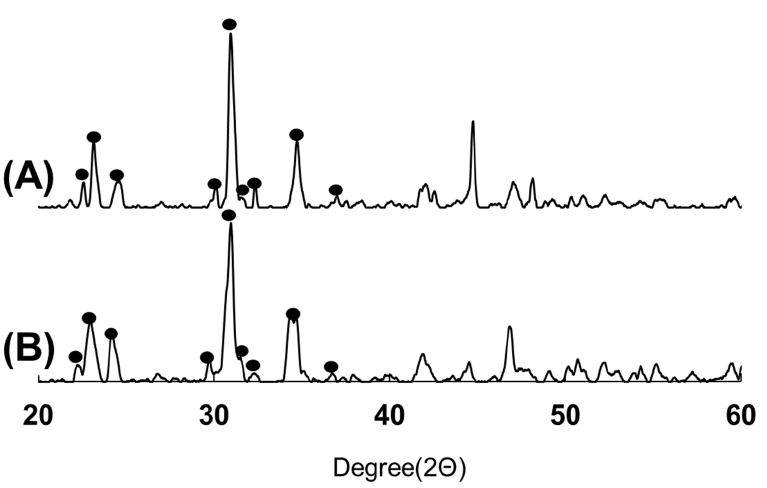
Figure 5. X-ray diffraction pattern of α -TCP/GS ( A ) and α -TCP particles ( B ); α -TCP/GS, composite gelatin sponge; α -TCP, alfa-tricalcium phosphate. The circles indicate the characteristic peaks of α -